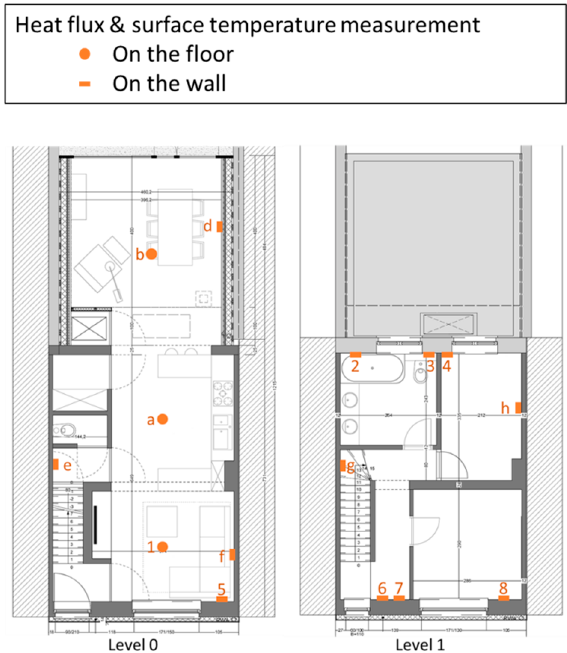
Figure 5. Monitoring campaigns: Sensor locations for the post-retrofit state of the dwelling.